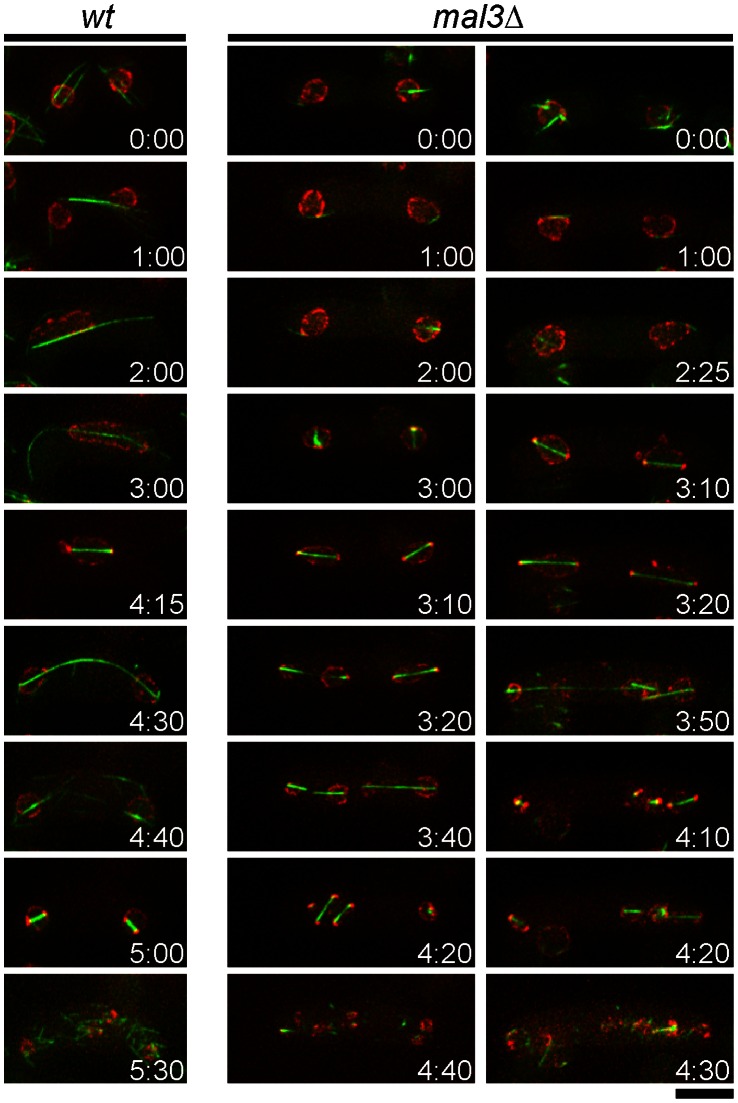
The mal3Δ strain initiates meiosis I before karyogamy is completed.Fluorescence micrographs of homothallic haploid cells of the wild-type (JT936) and mal3Δ (JT935) strains carrying the microtubule marker GFP-atb2 (green) and nuclear envelope marker cut11-3mRFP (red). Cells were subjected to nitrogen starvation to induce conjugation and meiosis. Serial images taken at indicated times (hr:min) are shown for each zygote. Bar = 5 µm.